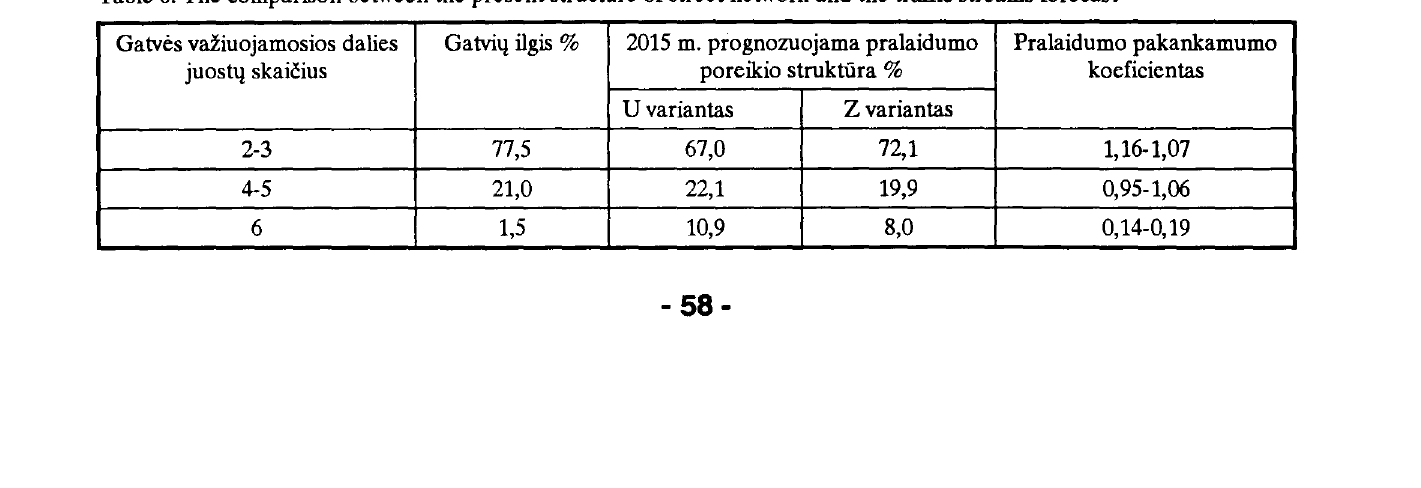
Table 6. The comparison between the present structure of street network and the traffic streams forecast Gatves vafiuojamosios dalies Gatviq ilgis